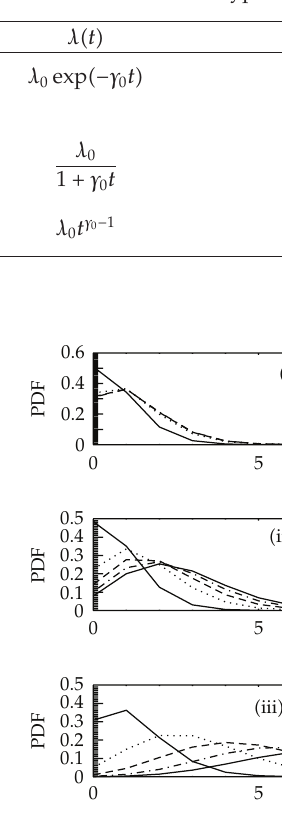
Table 1: Some typical examples of λ (cid:3) t (cid:4) and Λ(cid:3) t (cid:4) .